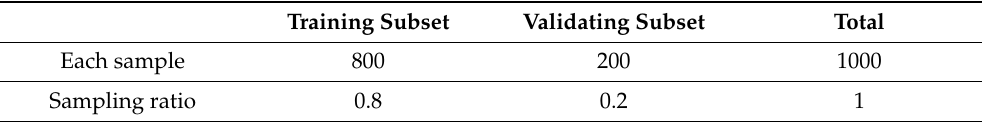
Table 2. The sampling methodology for the machine learning.